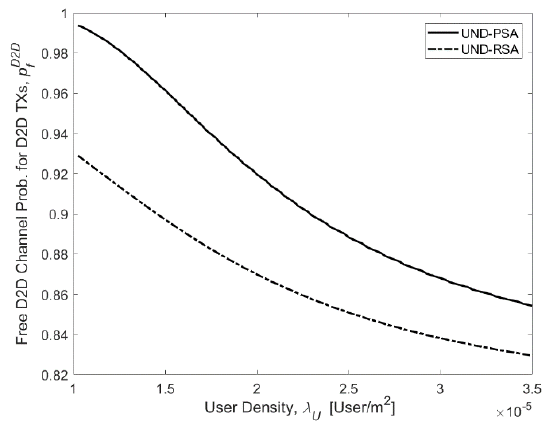
Figure 7. 𝑝 𝑓D2D vs. the density of users for the prioritized spectrum access (PSA) and random spectrum access (RSA) policies in the 𝐾 -tier HetNet.